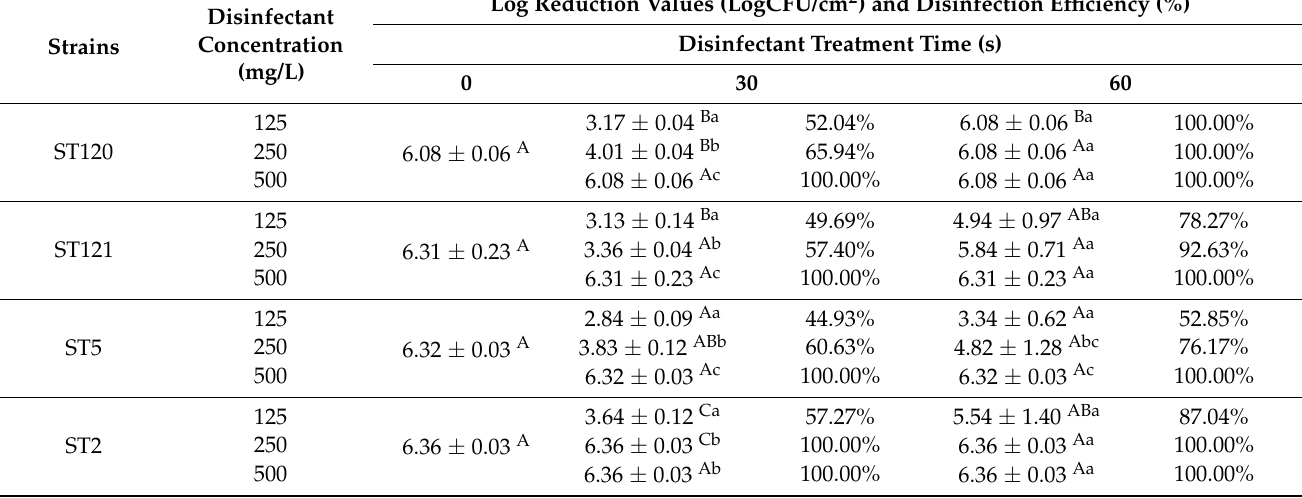
Table 2. Disinfection efficiency of chloride-containing disinfectant to four ST